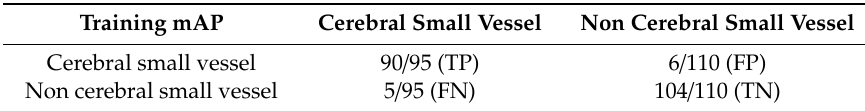
Table 2. Testing mAP of our proposed model. Table 3. Training mAP of YOLO1 model.